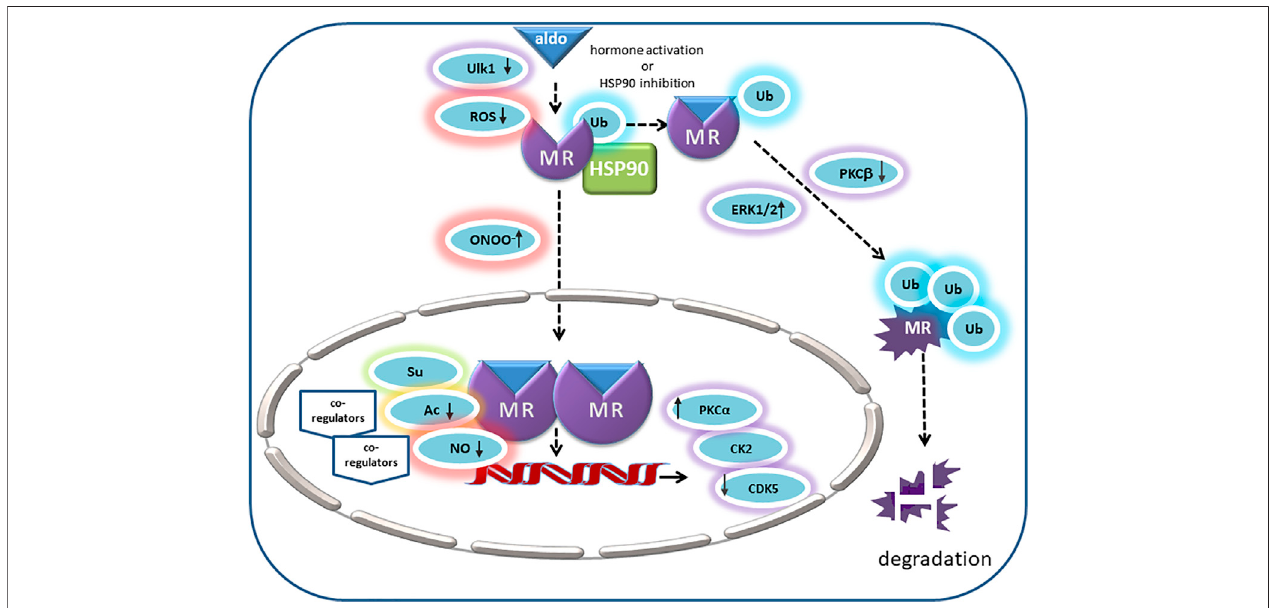
FIGURE 2 | In its unliganded state the MR is monoubiquitinated and located in the cytosol with chaperone molecules like HSP90. Its endogenous ligand aldosterone binds to MR in the cytosoland thereby triggers nuclear translocation. Ligand binding is inhibited by MR oxidation. In intercalated cells, autophagy activating kinase 1 (Ulk1) phosphorylates MR S843 in the LBD, mitigates its af fi nity for agonists and reducing its transcriptional activity. Peroxynitrite (ONOO-) can cause ligand- independentnucleartranslocationandactivationofMR.InhibitionofHSP90oractivationbyaldosteronecausespolyubiquitinationofMRanddegradation.ERK1/2 andPKCalsomodulateMRpolyubiquitinationanddegradation.PositiveregulatorsofMRtransactivationactivityarePKCaandCK2.Intheprescenceofcytokines,CK2 inhibits GREsignaling but promotes NFKB signaling and transcription ofpro-in fl ammatorycytokines. CDK5 inhibits MR transactivation in neuronal cells. Acetylation (Ac) and SUMOylation (Su)lead tomodulation ofaldosterone-activated MR transactivation bydirectand indirect effects. NOattenuates bindingofMRtoDNA, consequently reducing the MR ’ s transcriptional activity ( ↑ (cid:2) stimulatory effect; ↓ (cid:2) inhibitory